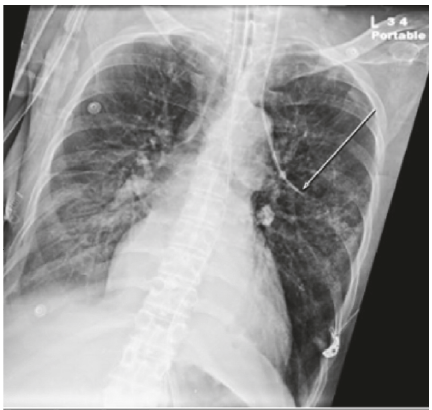
Figure 1: Single frontal view CXR showing the tip of the left IJ CVL extending left of the aortic arch towards the left lung field.